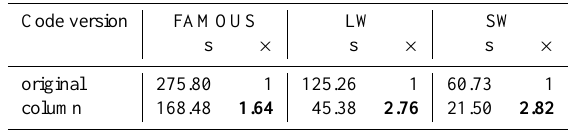
Table 5. The computation time (in seconds) and the speed im- provement (’ × ’ column) for FAMOUS, the long-wave (LW), and short-wave (SW) radiation for the different versions of the radiation algorithm on the Intel test platform.